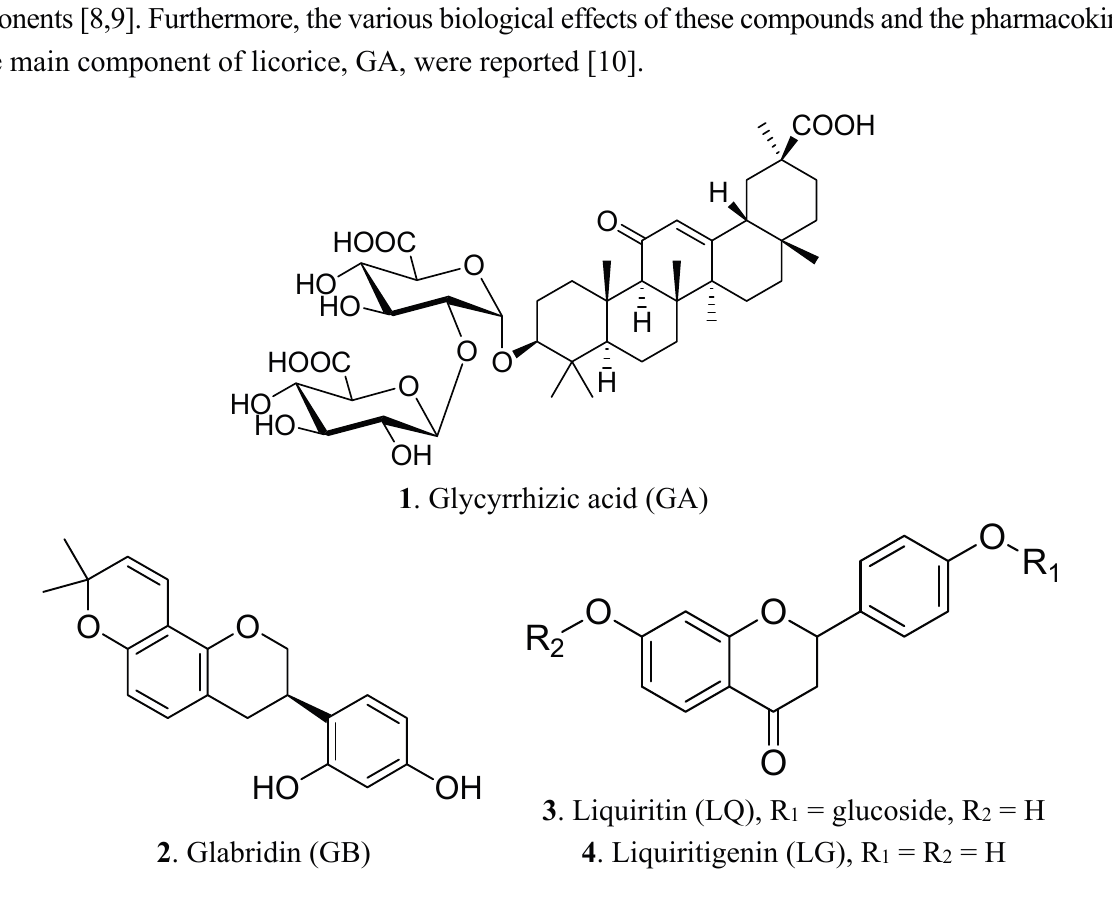
Figure 1. Structures of glycyrrhizic acid 1 (GA), glabridin 2 (GB), liquiritin 3 (LQ) and liquiritigenin 4